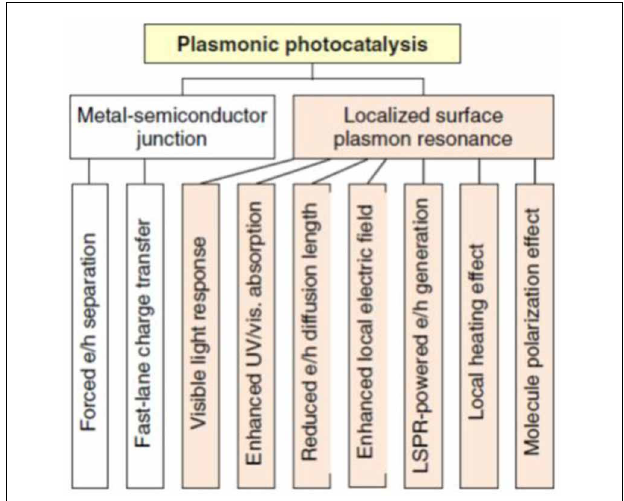
FIGURE 4 | Summary of advantages of plasmonic photocatalysis. [Reprinted with permission of reference Zhang et al. (2013). Copyright 2013